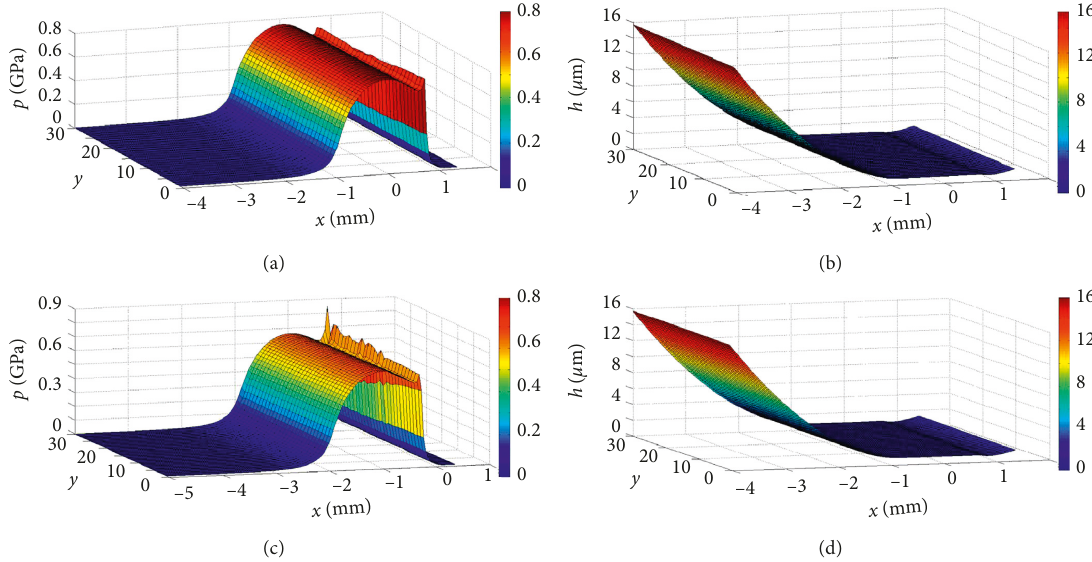
Figure 10: Distribution of film pressure and thickness under the outer and inner raceway contact conditions: distribution of (a) film pressure of the inner raceway; (b) film thickness of the inner raceway; (c) film pressure of the outer raceway; (d) film thickness of the outer